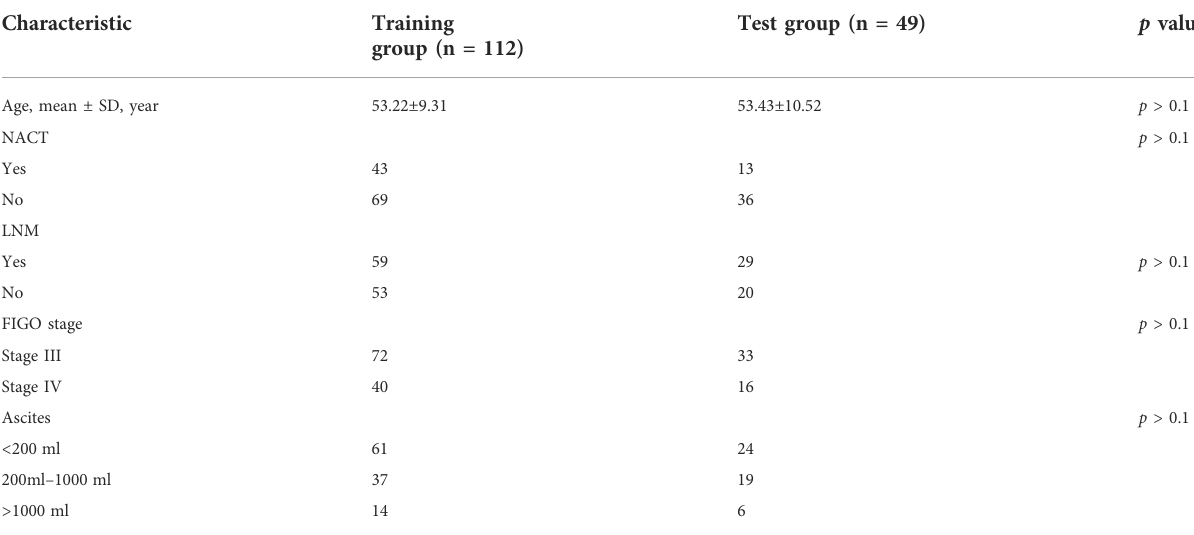
TABLE 1 Clinical characteristics of HGSOC patients in training and test groups.